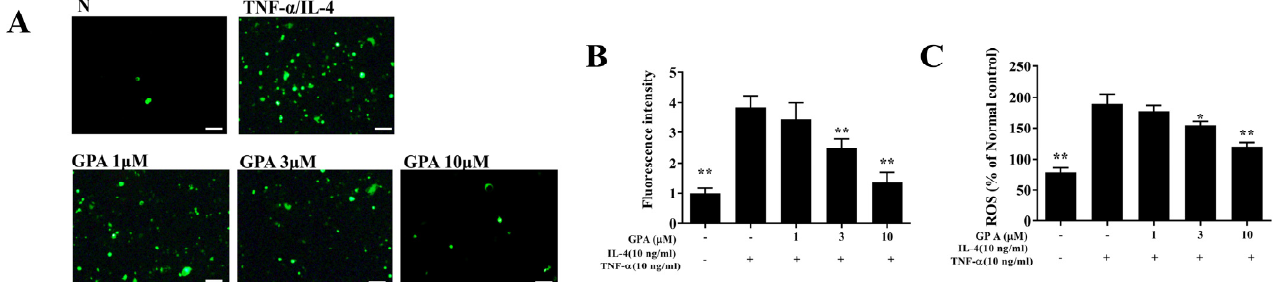
Figure 7. Effects of gypenoside A (GPA) on ROS production in activated BEAS-2B cells. ( A ) Fluo- rescence microscopy images of intracellular ROS (scale bar = 100 µm). ( B ) Fluorescence intensity of intracellular ROS. ( C ) ROS levels detected in TNF- α /IL − 4-activated BEAS-2B cells with or without gypenoside A as percentages of the levels in untreated cells (N). The data are presented as the mean ± SEM of three independent experiments. * p < 0.05, ** p < 0.01 compared to BEAS-2B cells stimulated with TNF- α /IL-4.